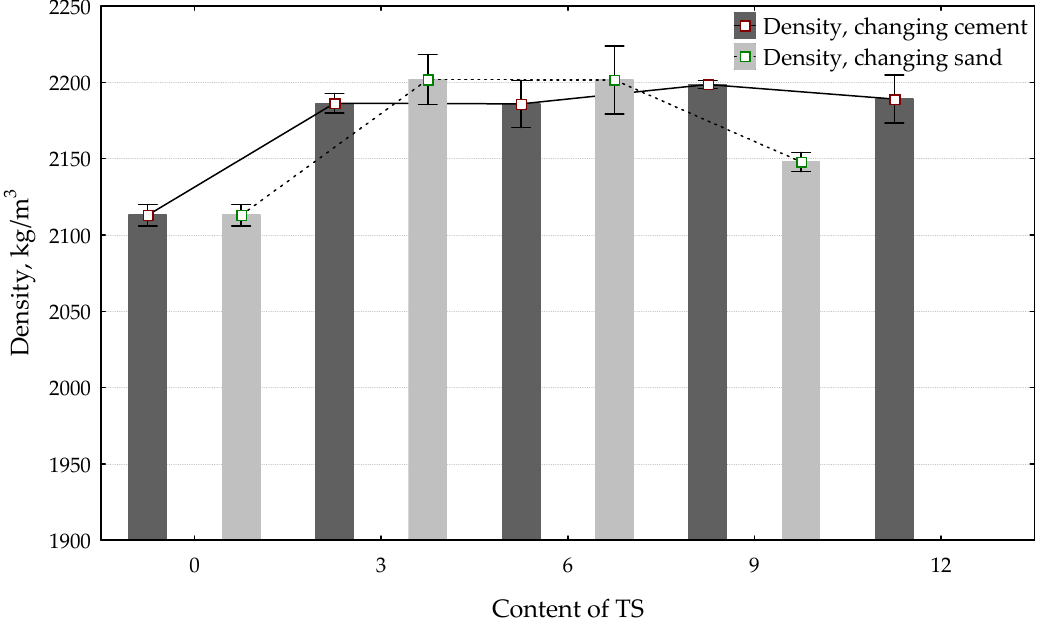
Figure 4. The impact of TS content in the mix on mortar density.